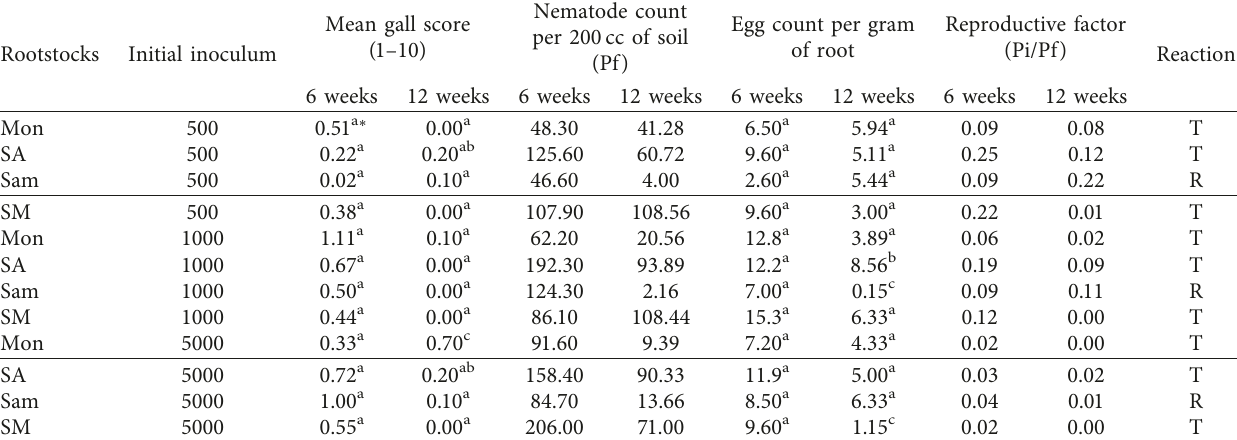
Table 2: Response of four rootstocks to four RKN inoculum levels on gall scores, egg count per gram of root, and reproductive factors 6 and 12 weeks after inoculation in pot